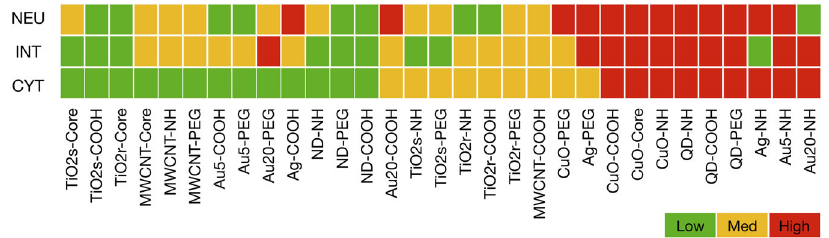
Fig. 2 Classi fi cation tasks identi fi ed for the ENM safety classi fi er. Three different grouping approaches are proposed for ENM safety assessment. The 31 ENMs were fi rst grouped on the basis of cytotoxicity data (CYT). Then, the second grouping of ENMs was de fi ned based on an integration of genotoxicity, cytotoxicity, and immunotoxicity data using in vitro assays (designated as INT). Finally, the neutrophil count in BAL fl uid was used to de fi ne the third categorization of ENMs re fl ective of their in vivo toxicity (NEU). Green represents a low hazard, yellow represents a medium hazard, and red represents a